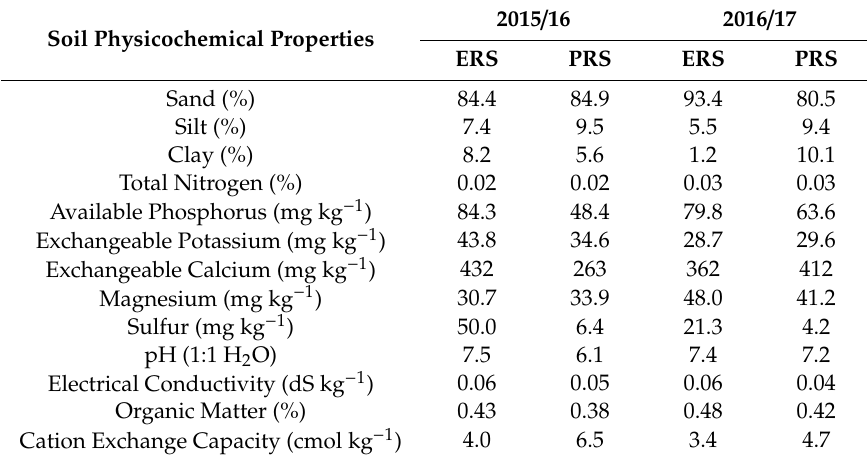
Table 1. Soil physicochemical properties at pre-planting by averaging from two soil layers (0–30 cm and 30–60 cm) in the early rainy seasons (ERS) and post rainy seasons